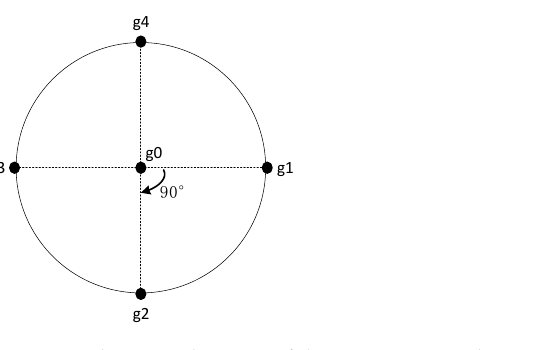
ρ 1 ρ 3 Figure 5. Schematic diagram of the sensor array. According to the geometric position relationship between the sensor array and the transmission line in the above figure, in △ P ’ Og1, using the cosine theorem, it is obtained that: